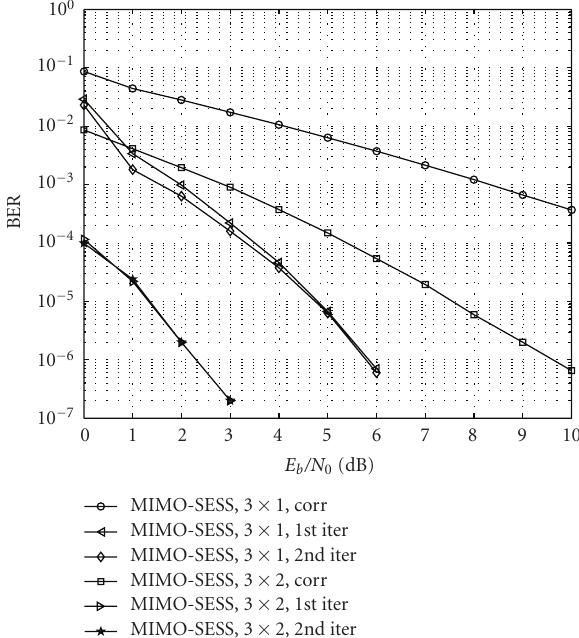
Figure 7: Performance of the proposed MIMO-SESS system with iterative detection, three transmit antennas using half-rate code G 3 , N =